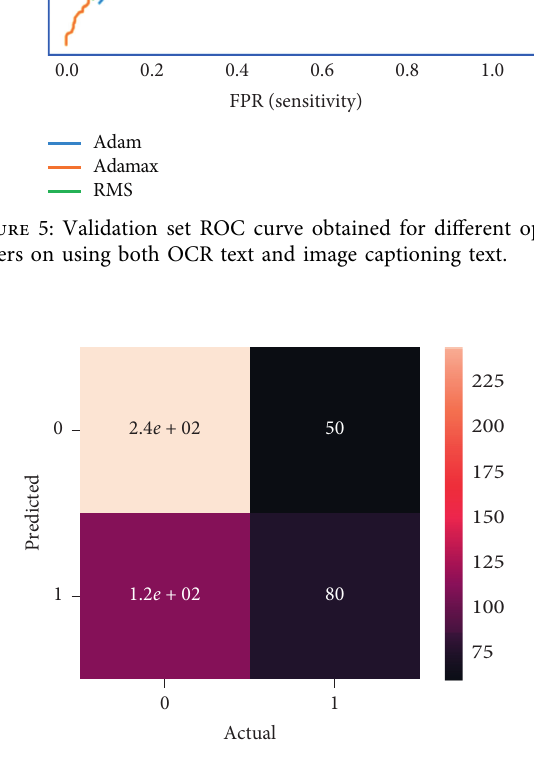
Figure 6: Confusion matrix obtained on using Adamax optimizers used in sequential approach on validation set. Table 3: Comparative analysis. S. no.